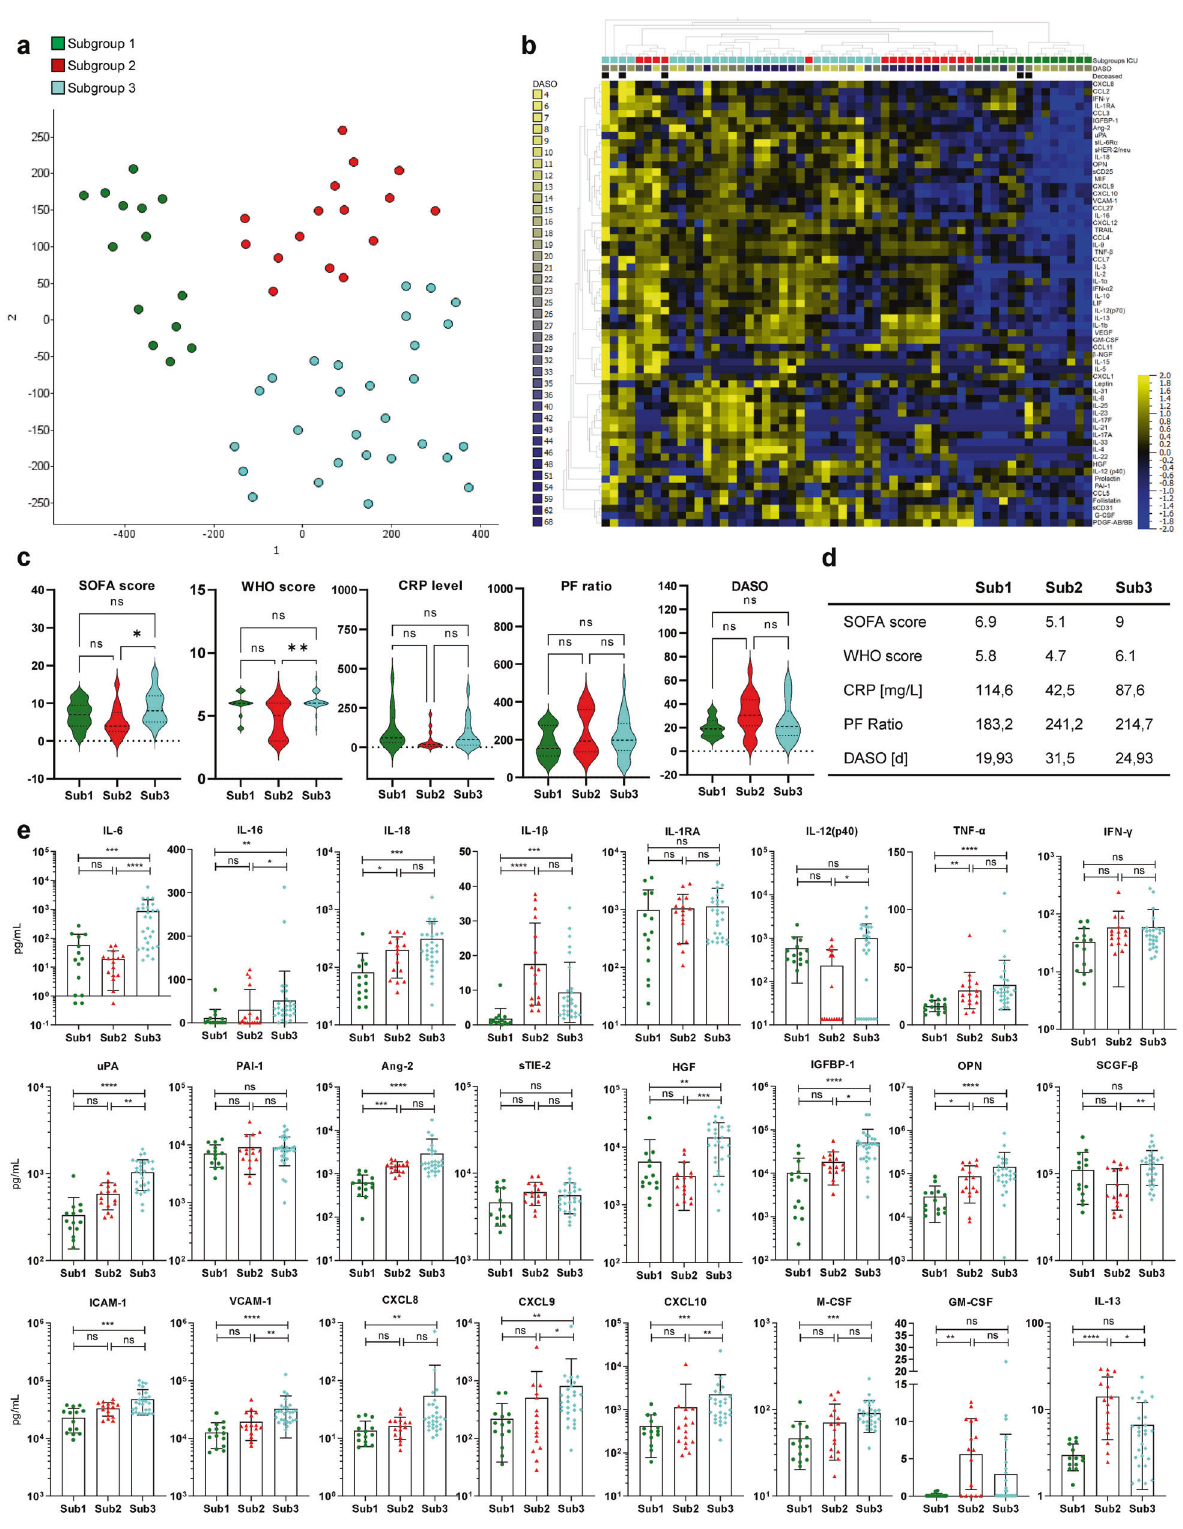
Sub1 and Sub3. Together with decreased pro-in fl ammatory protein pro fi le and clinical data, Sub1 patients are considered as patients at the beginning of a severe COVID-19 progression